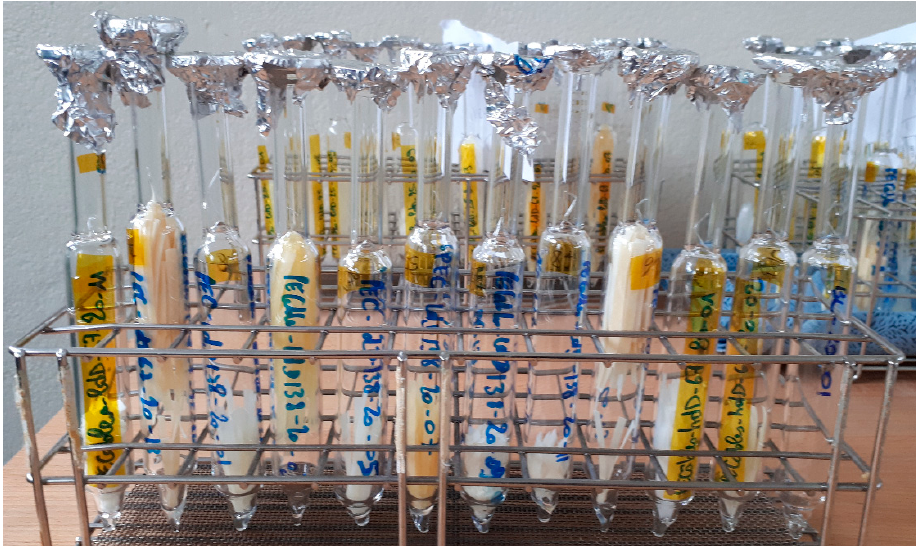
Figure 2. Photos of glass closed ampoules, which contain polymer.